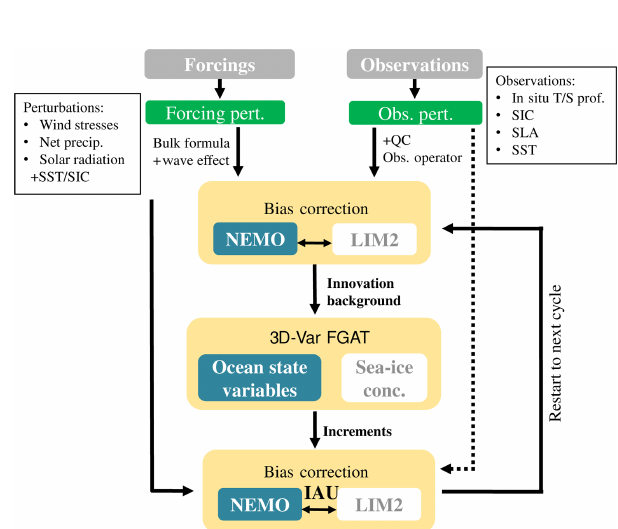
Figure 1. Schematic diagram of the ORAS5